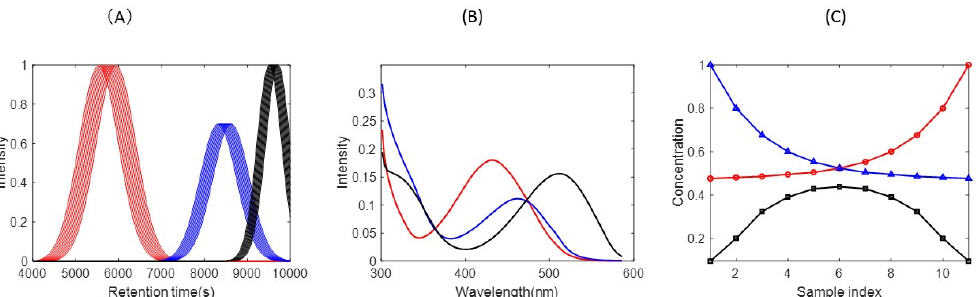
Figure 2. ( A ) Elution (left), ( B ) spectral (middle), and ( C ) sample (right) profiles of three-way dataset 1. Observe the large shifts in the peaks of the elution profiles of the three components in the different chromatographic runs (middle plots). The profiles of the three components are shown in different colors.